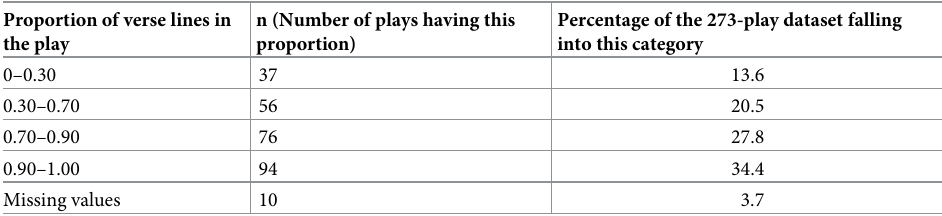
Table 2. Plays segmented into three categories of proportions of verse lines.